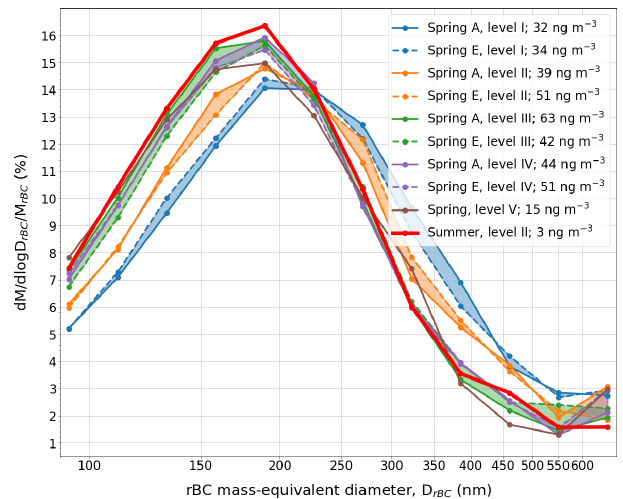
Figure 9. Averaged rBC mass size distributions normalised with the total mass concentration under the curve for levels I–V from the spring polar dome observations around Alert (A) and Eureka (E), as well as for level II from the summer polar dome observations around Resolute